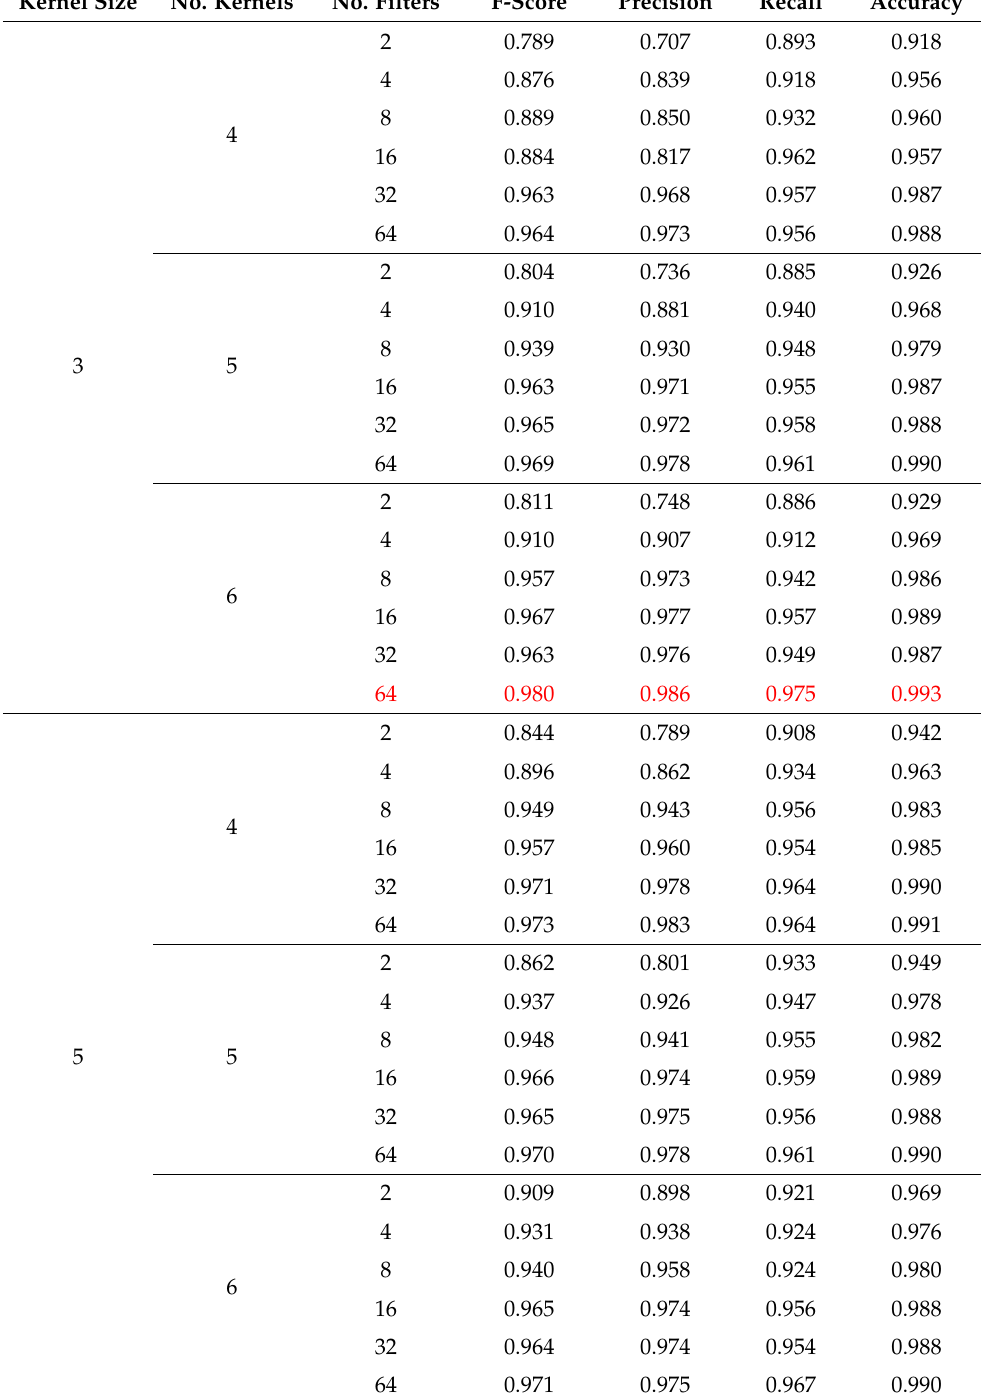
Table 6. Evaluation of CNN-based fault